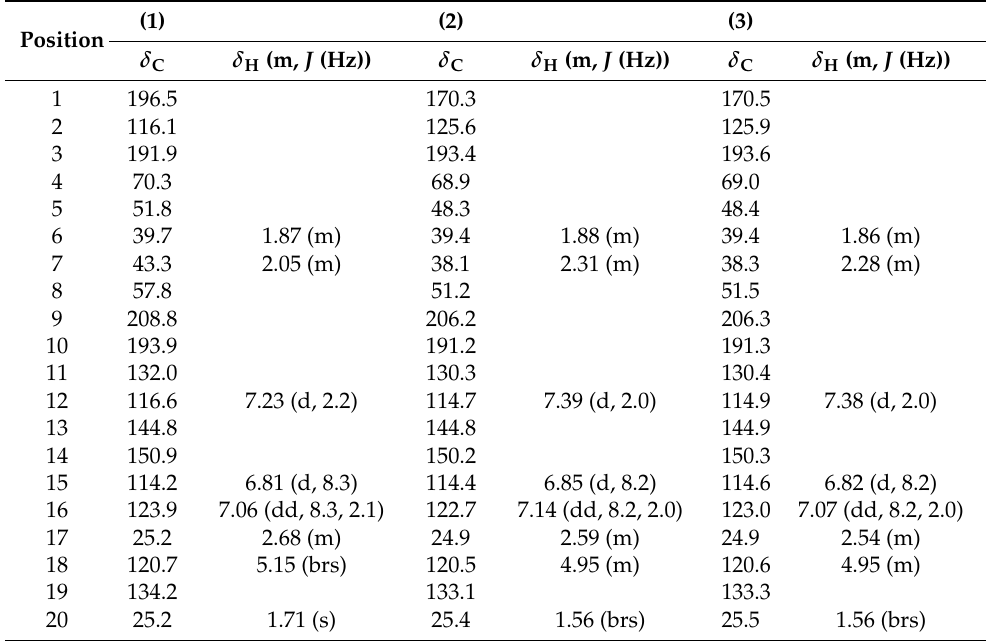
Table 1. 1 H (600 MHz) and 13 C (150 MHz) NMR data of compounds 1 – 3 in acetone- d 6 ( δ in ppm).